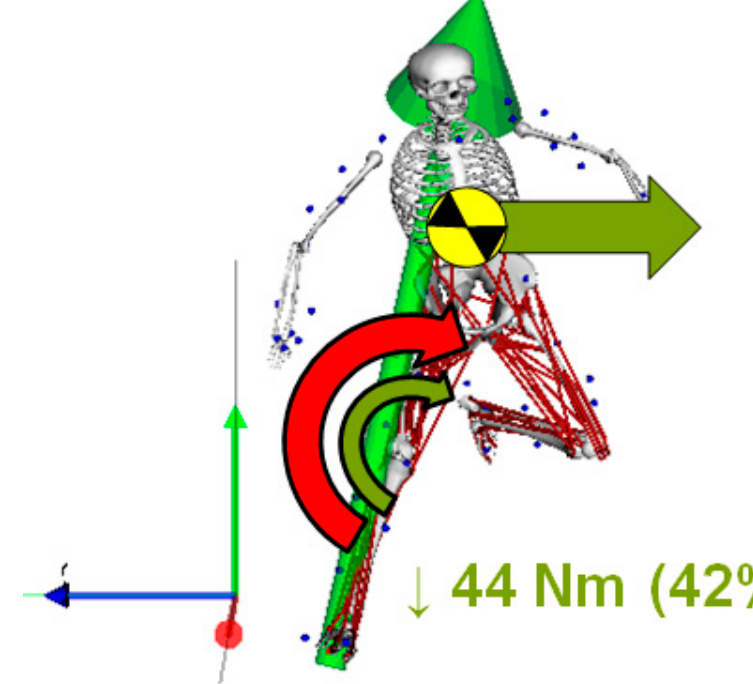
Figure 3. Overview of upper body mechanics and peak valgus knee moments during unplanned sidestepping.